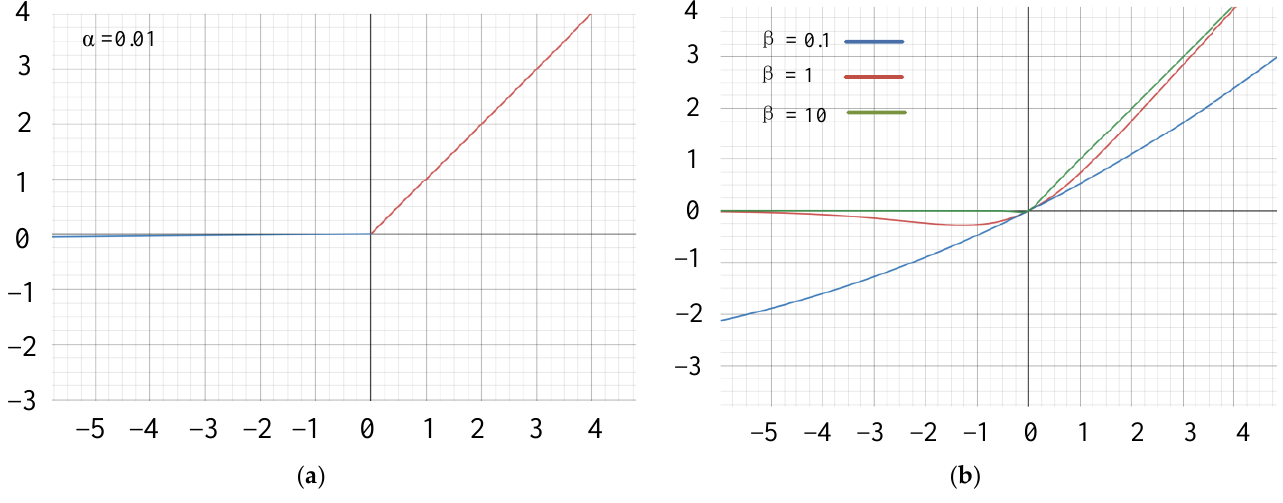
Figure 5. Activation function. ( a ) LReLU function. ( b ) Swish function.